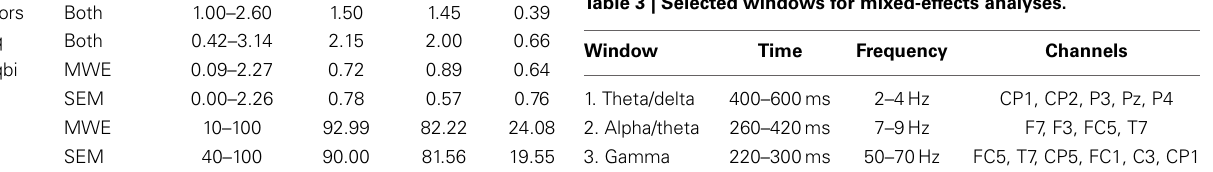
Table 3 | Selected windows for mixed-effects